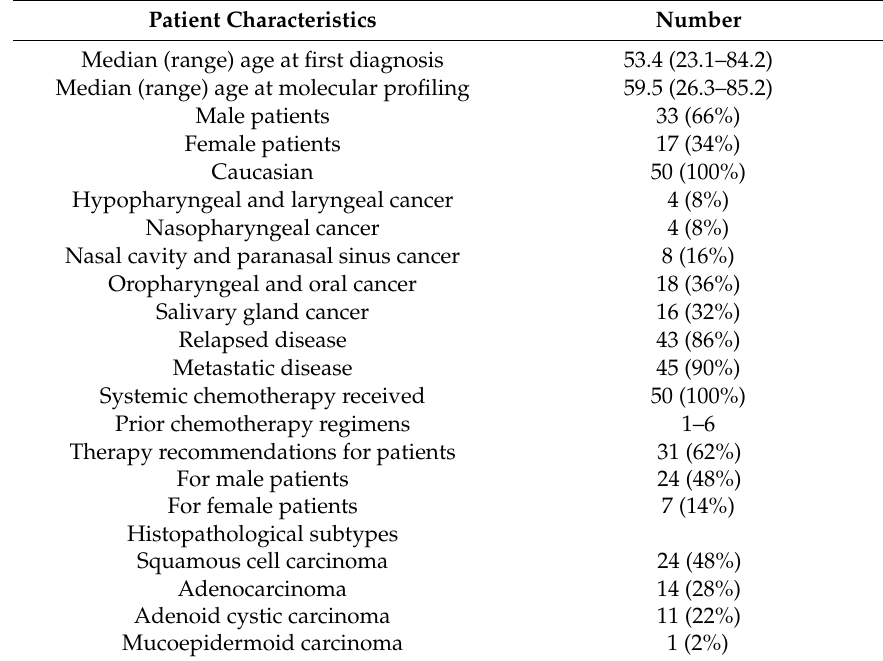
Table 1. Patient characteristics ( n =